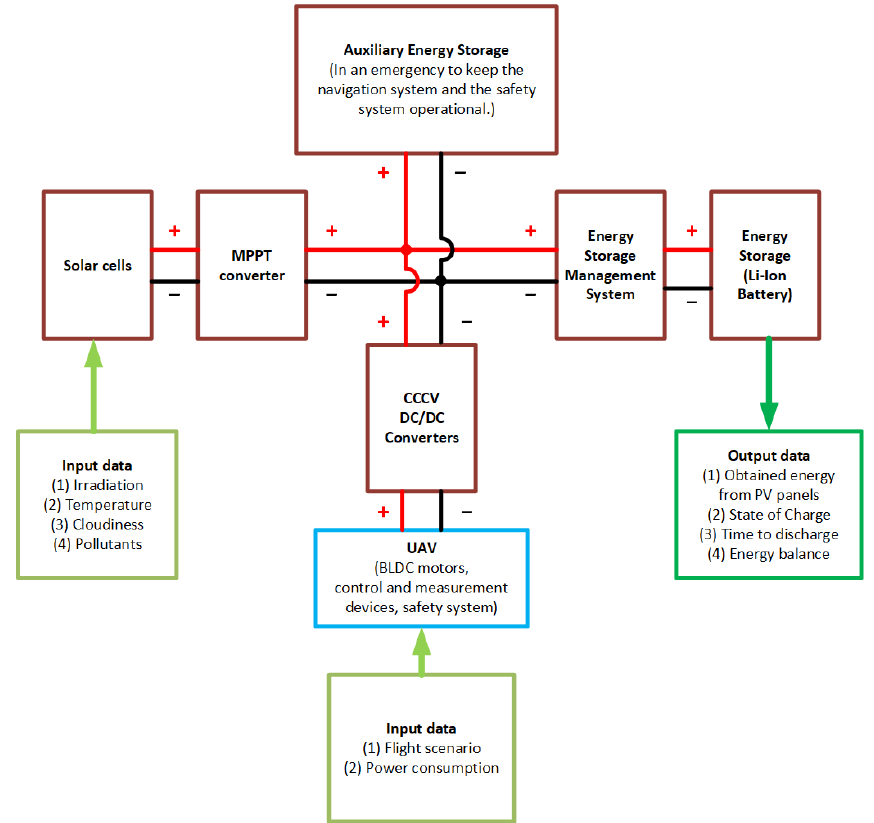
Figure 9. General diagram of the TwinStratos power supply system.